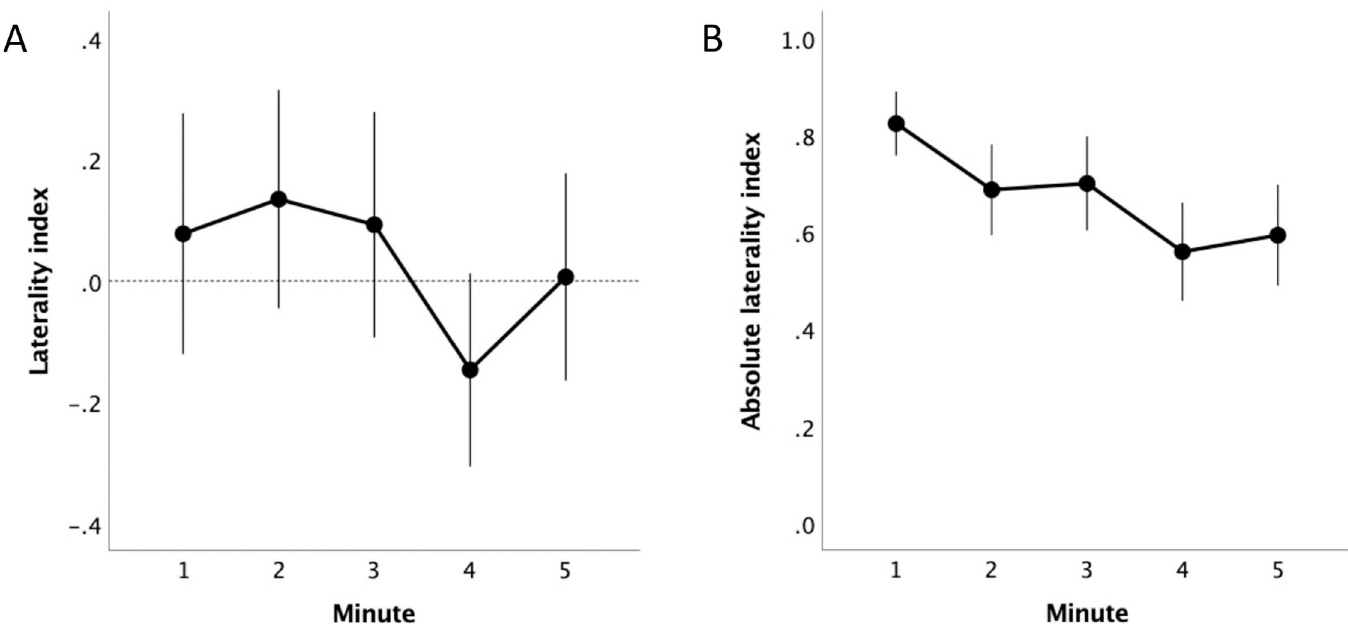
Fig 4. Direction and strength of eye use preference over time. (A) preference for inspecting the balloon with the left versus the right eye (laterality index). The eye use preference changed significantly across the trial (effect of minute; p = 0.01). (B) the strength of eye use preference (absolute laterality index). Horses inspected the balloon with their non-preferred eye significantly more as the trial progressed (effect of minute; p <